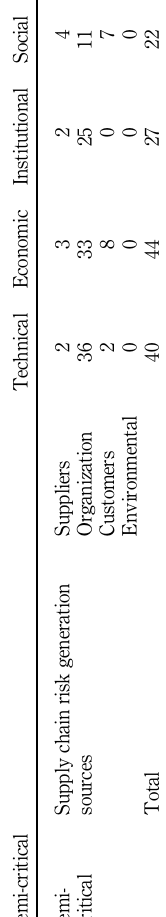
Table 5. Distribution of semi- critical risks by supply chain risk generation resources and sustainable development